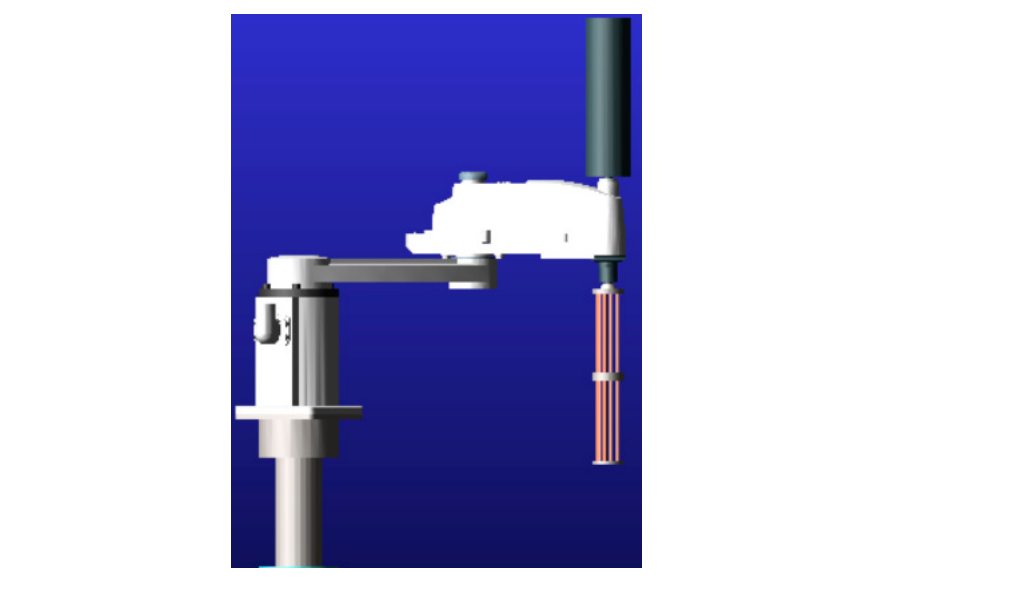
Figure 9. Cosimulation model of continuum robot system.